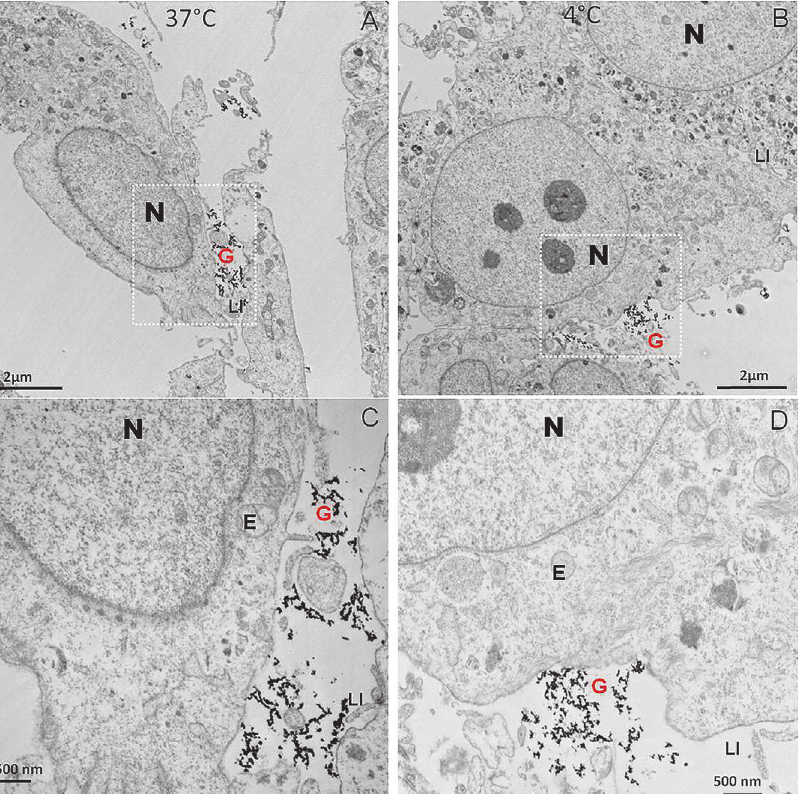
Fig 1. TEM micrographs of UROtsa cells demonstrate the lack of any internalization of colloidal gold particles in absence of liposomes by absence of any dark grains inside the cells. Compared to faint to dark grey color of uranyl acetate staining acquired by other cell organelles and electron dense gold particles appear as dark grains. UROtsa cells incubated at either 37°C (Panel A&C) or at 4°C (Panel B&D) showed similar absence of any dark grains inside the endosome marked by E in all the panels to indicate uptake was independent of temperature. Inscribed area of panel A and B in white rectangle is magnified 3 times further in panel C and D, respectively. UROtsa cells have prominent large nucleus shown by N and cells are marked by finger like projections called lateral interdigitation (shown by LI) for connecting with adjacent cells. Plain gold is marked by red colored G, Magnification is shown by the scale bar in each